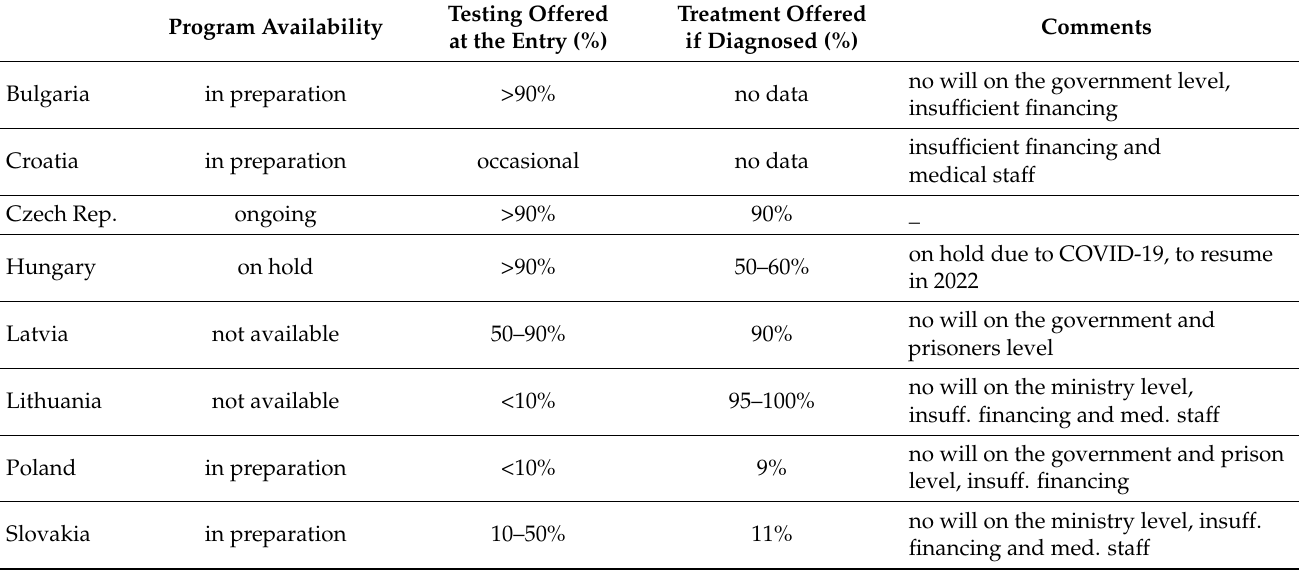
Table 4. Availability of national screening programs in prisons in particular